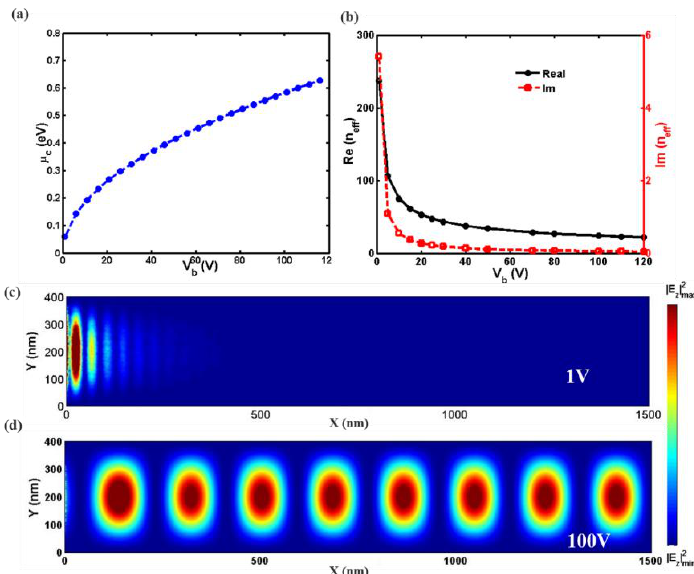
Figure 2. ( a ) Dependence of chemical potential µ c on the bias voltage with h = 50 nm; ( b ) The real and imaginary parts of the effective index of graphene-based surface plasmons (SPs) as functions of the gate voltage V b . Distributions of | E z | 2 in the x - y plane of the waveguide ( h = 50 nm, f = 30 THz), in the ( c ) OFF and ( d ) ON